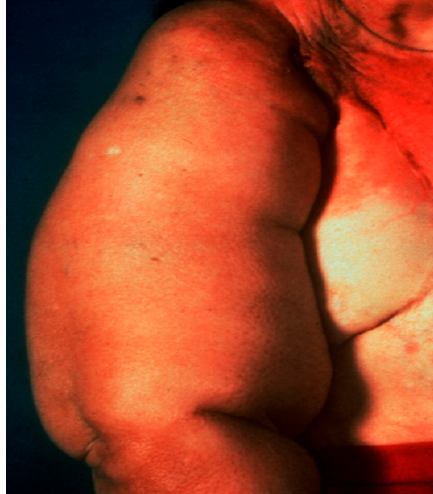
Figure 1. Lymphedema following axillary lymph node dissection.